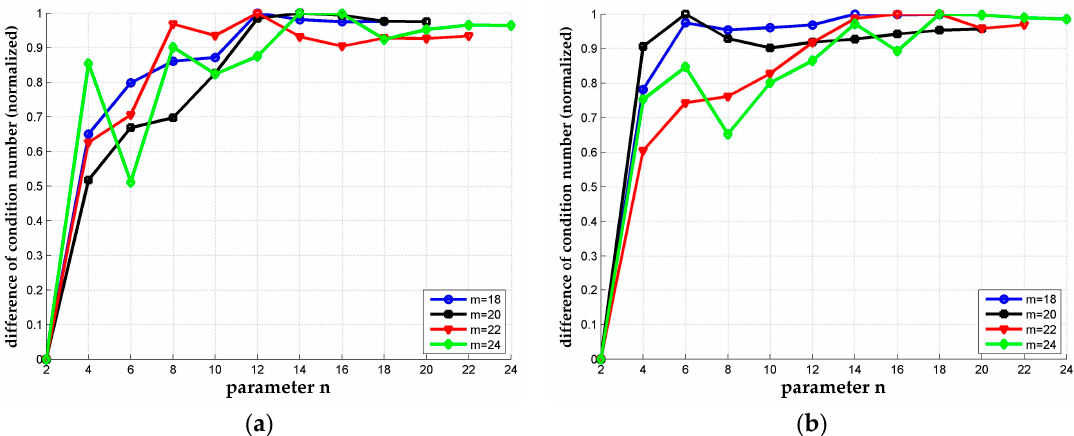
Figure 4. Normalized difference of condition numbers. The differences of condition number between n -LLL and the original LLL are normalized and plotted altogether with m range from 18 to 24. ( a ) The normalized difference of condition number for κ orig = 2 14 of Case 1; ( b ) The normalized difference of condition number of Case 2.